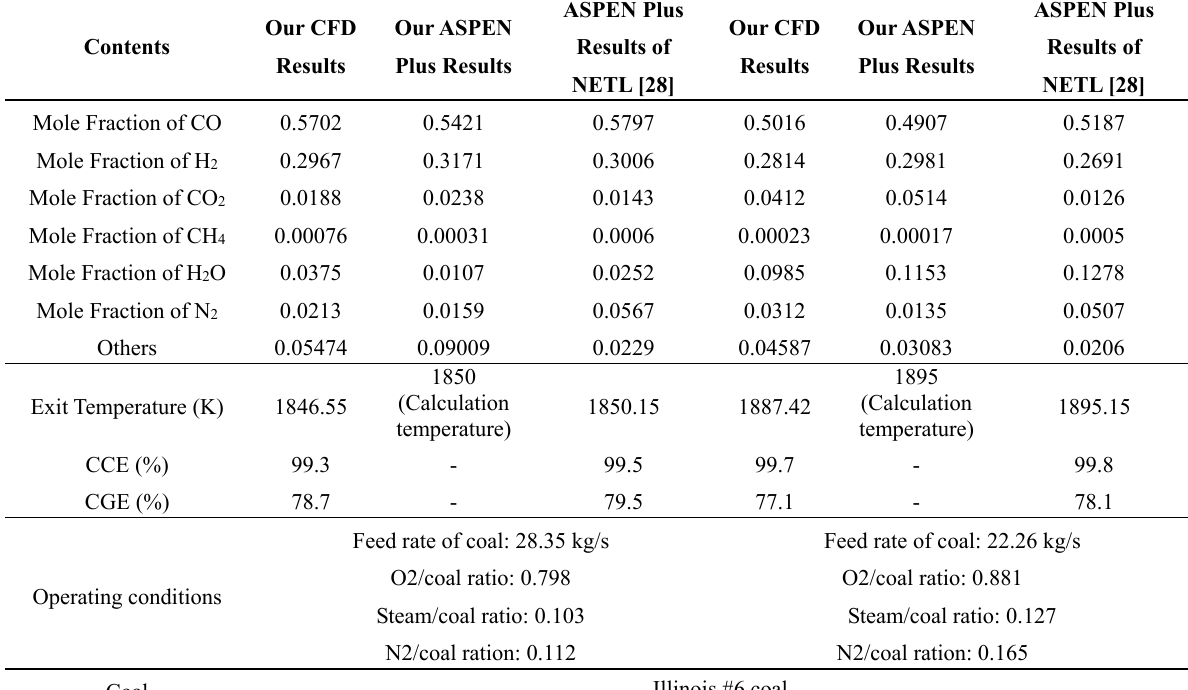
Table 6. Comparison of the CFD results with ASPEN Plus results of NETL